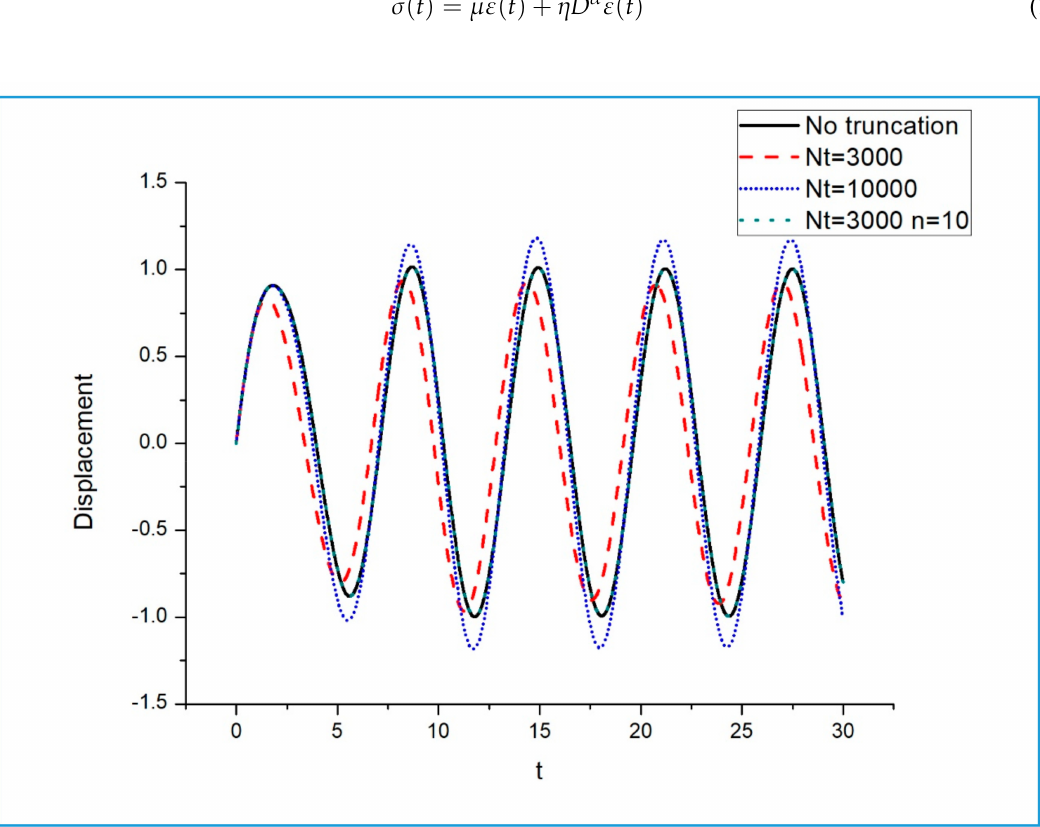
Figure 12. Forced vibration